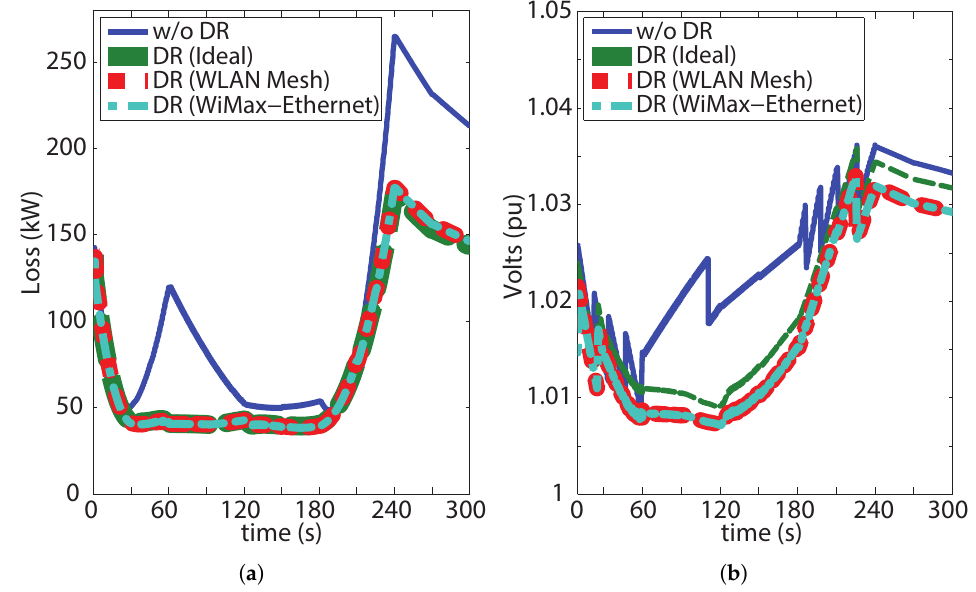
Figure 11. The power loss and the voltage of 13 Node system. ( a ) Total power loss; ( b ) Voltage of 652